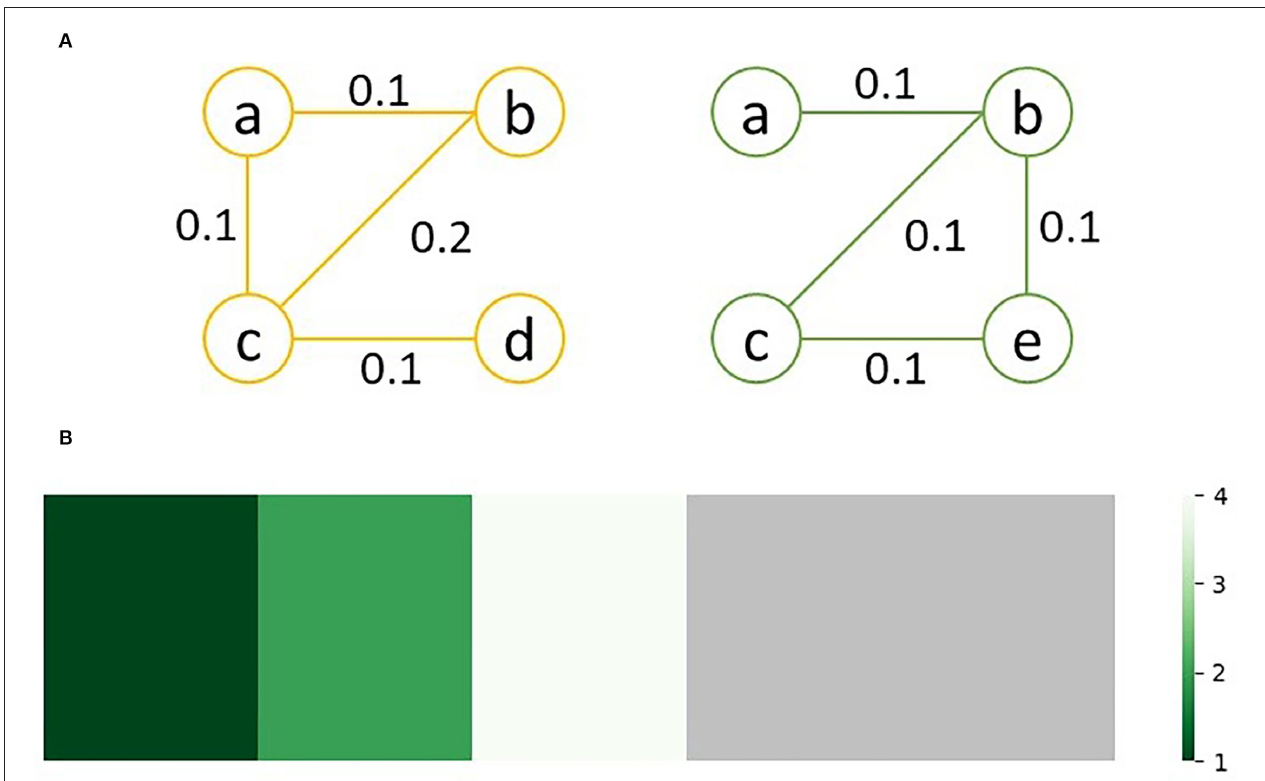
FIGURE 2 | Graph comparison between (A) two sample graphs, G 1 (left) and G 2 (right); (B) shows the heatmap visualization of the edit distances between G 1 and G 2 , with the green regions representing similarity between he graphs and gray regions representing differences; the ration between the regions visually represents how similar the two graphs